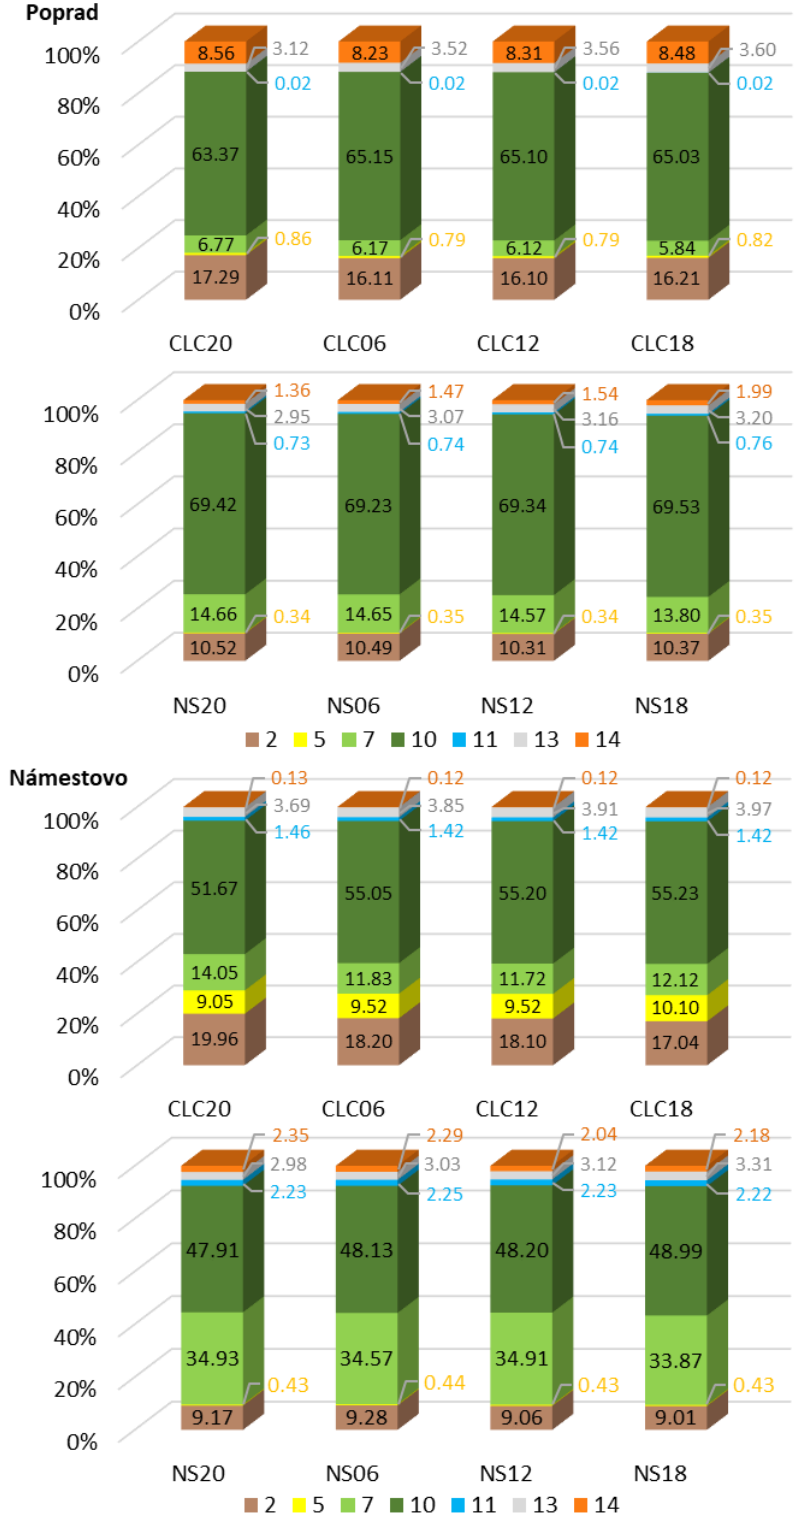
4 Figure 4. Development of relative LU values for the counties of Poprad and N á mestovo according to recorded NS and CLC3 data in 2000, 2006, 2012, and 2018, respectively. LU codes according to NS: 2 arable land, 5 gardens, 7 permanent grassland, 10 forest land, 11 water bodies, 13 built-up areas and courtyards, and 14 other